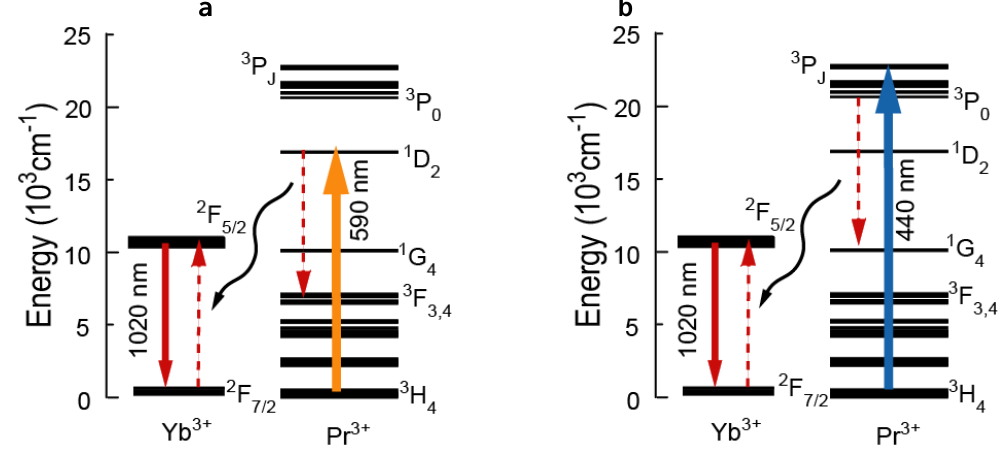
Figure 5. Energy transfer mechanisms of Pr 3+ and Yb 3+ excited at (a) 590 nm and (b) 440 nm.